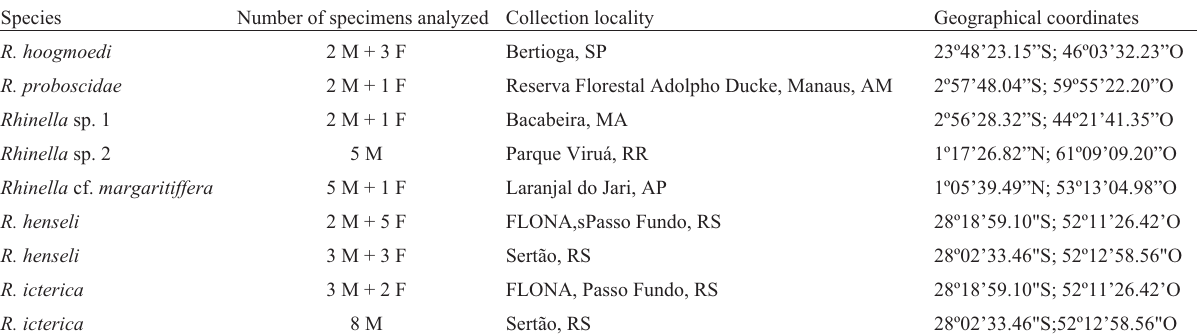
Table 1 - Number of Rhinella specimens analyzed and their localities in